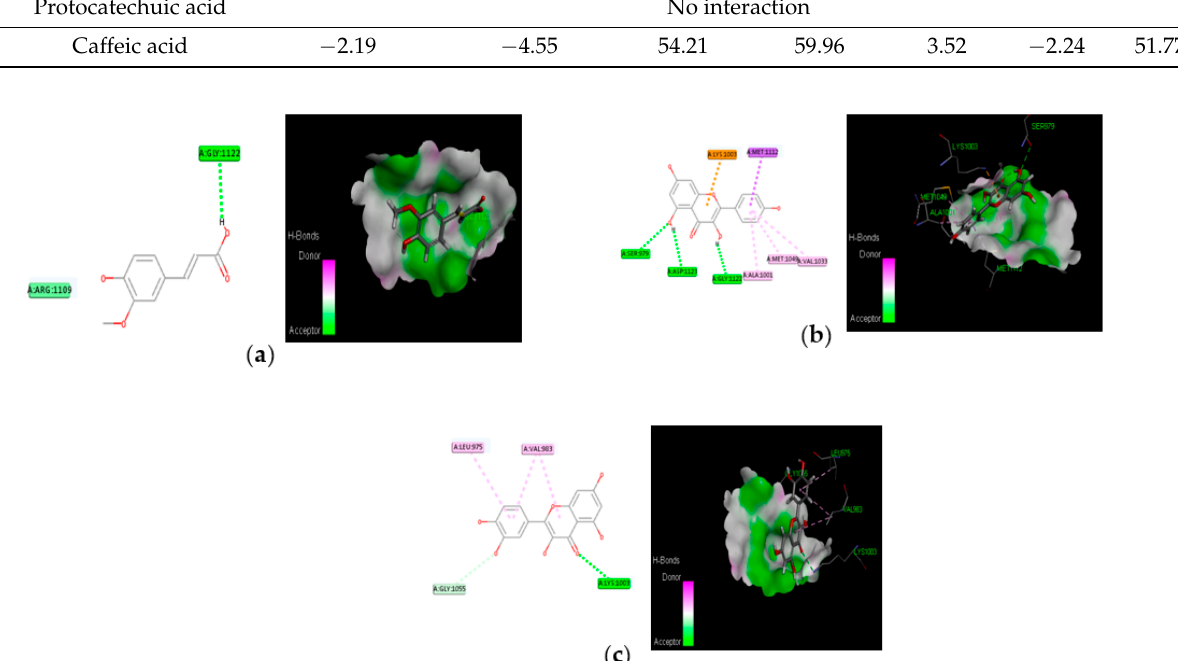
Figure 6. Molecular interaction of best three compounds with IRS-1; ( a ) trans-ferulic acid; ( b ) kaempferol; ( c ) quercetin.